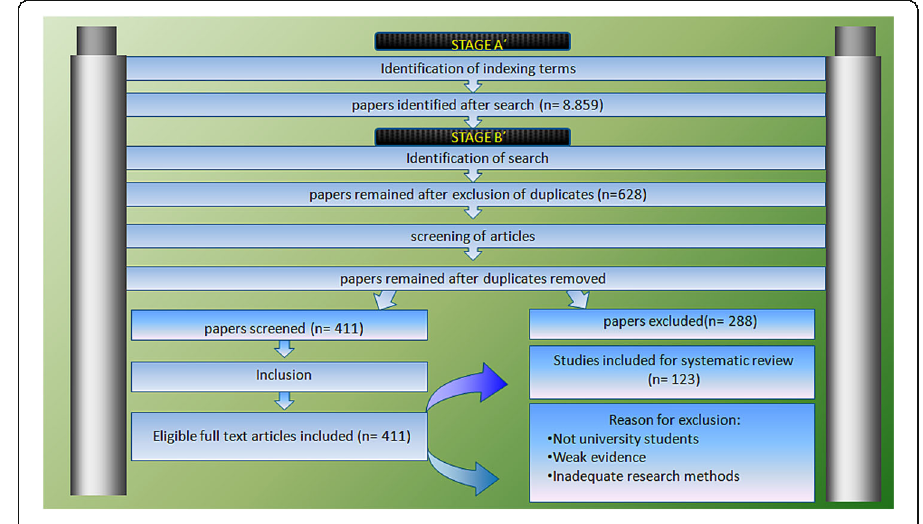
Fig. 3 Research review methodological